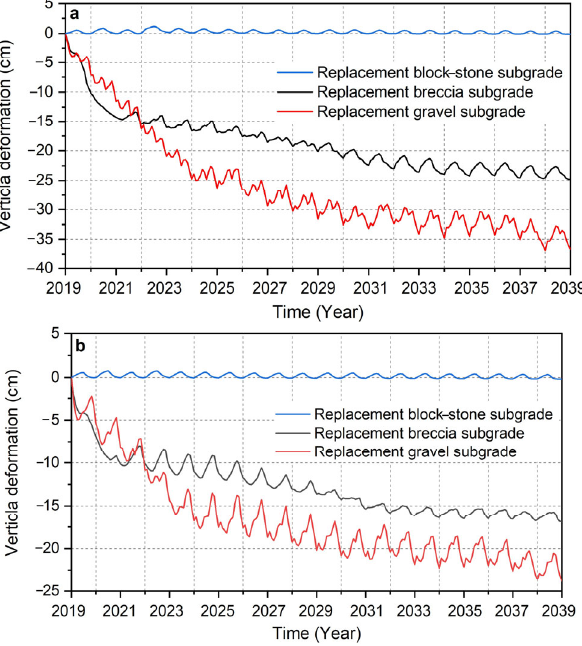
Figure 17. Vertical deformation curves at the road centerline and the shoulder of the three subgrade structures in Case 2: ( a ) at the road centerline and ( b ) at the shoulder.